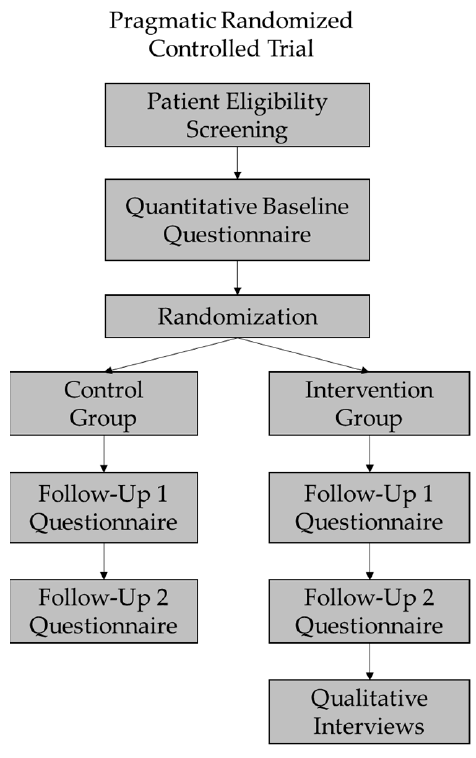
Figure 1. Sequence of patient quantitative and qualitative data collection.